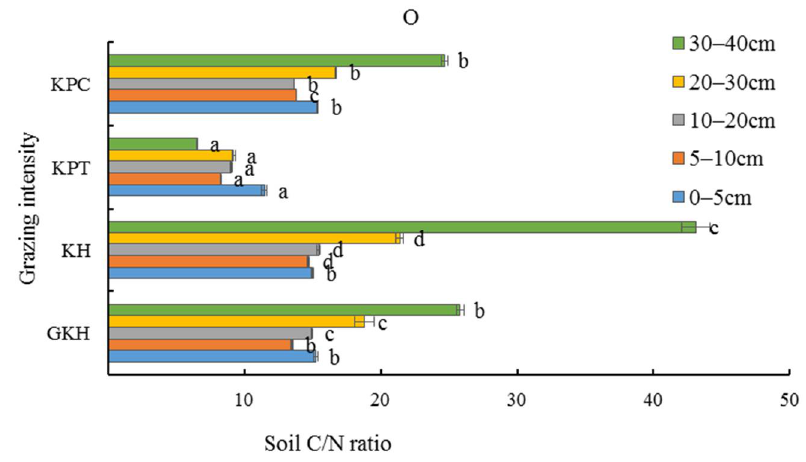
Figure 10. Soil C/N ratio (total carbon/total nitrogen) in the plant community at different grazing intensities: GKH (3.75 ± 0.75 sheep/ha), KH (7.25 ± 0.25 270 sheep/ha), KPT (8.50 ± 0.35 sheep/ha), and KPC (11.75 ± 0.95 sheep/ha). Notations: different letters indicate significant differences between pastures ( α = 0.05).